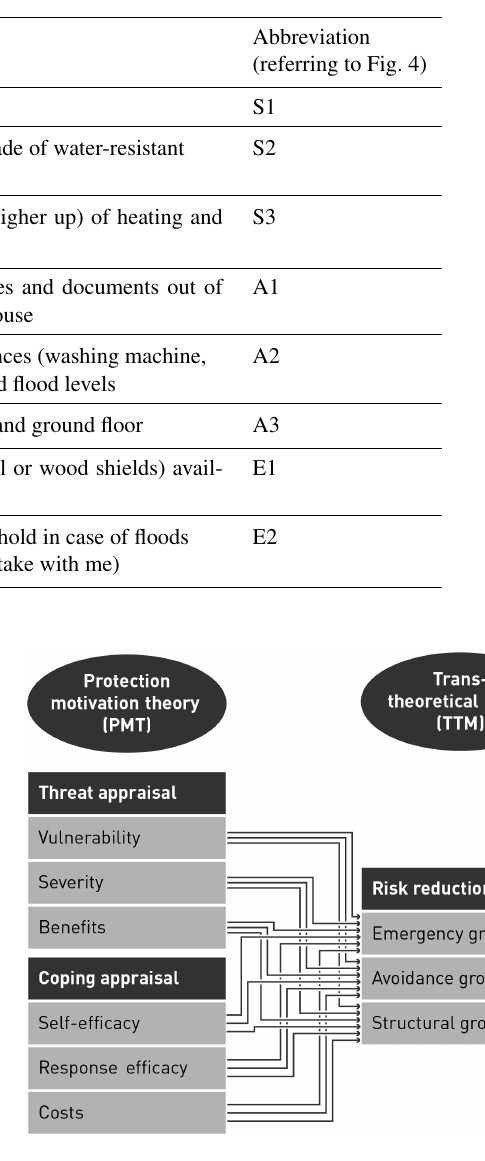
Table 1. Overview of risk reduction behaviours.